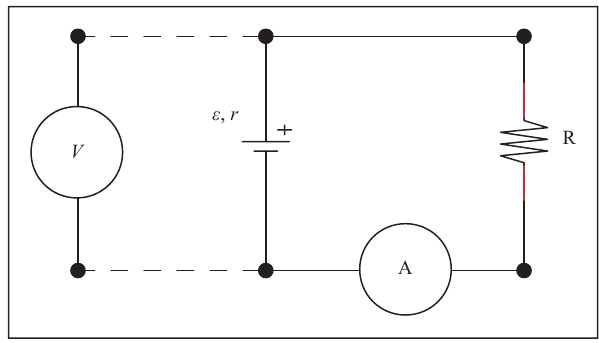
Fig. 3. Real battery and the variations of the current and potential